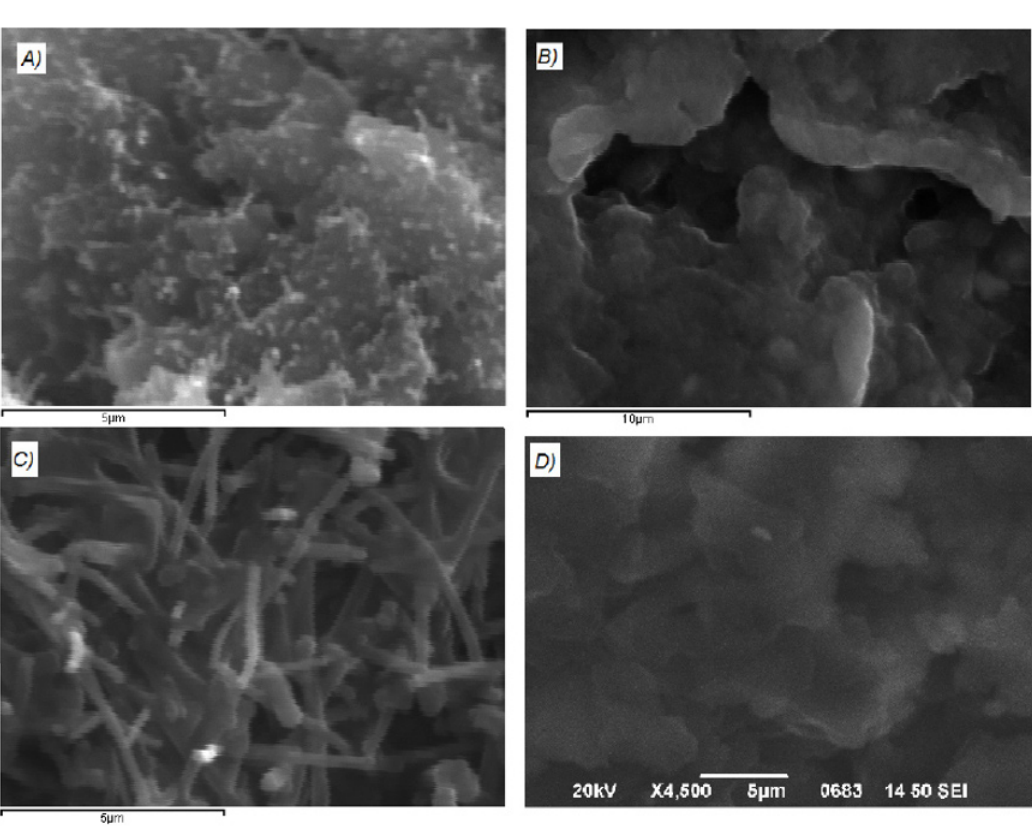
Figure 4. SEM images of A) CPE, B) MWNTPE